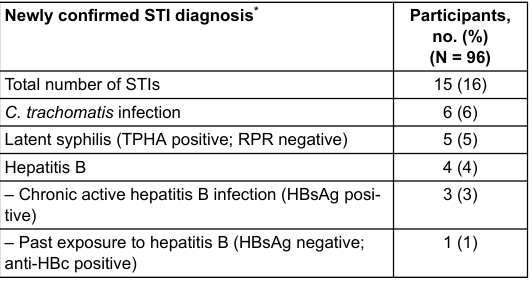
Table 3: Prevalence of sexually transmitted infection (STIs) among fe- male sex worker participants – Lausanne, Switzerland, 2015-16. Newly confirmed STI diagnosis * Participants,